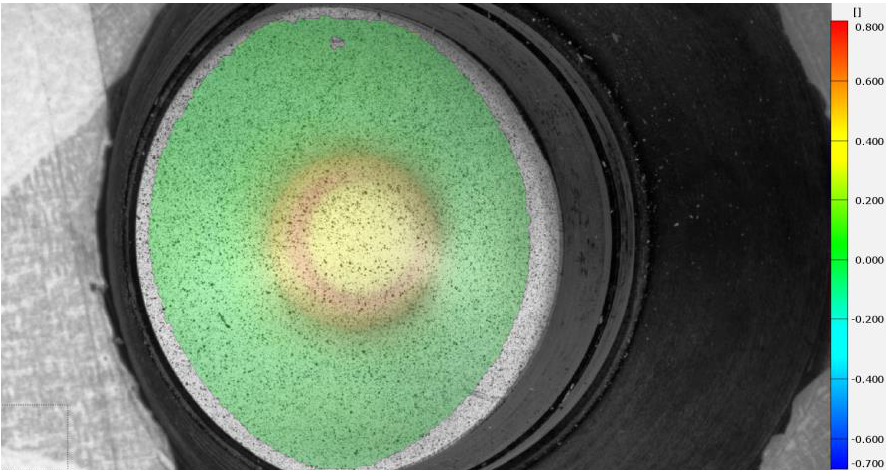
Figure 15. S2 sample plate with P7/SC2 painting and cleaning process (the legend, i.e., the color map, gives the deformation in mm unit).